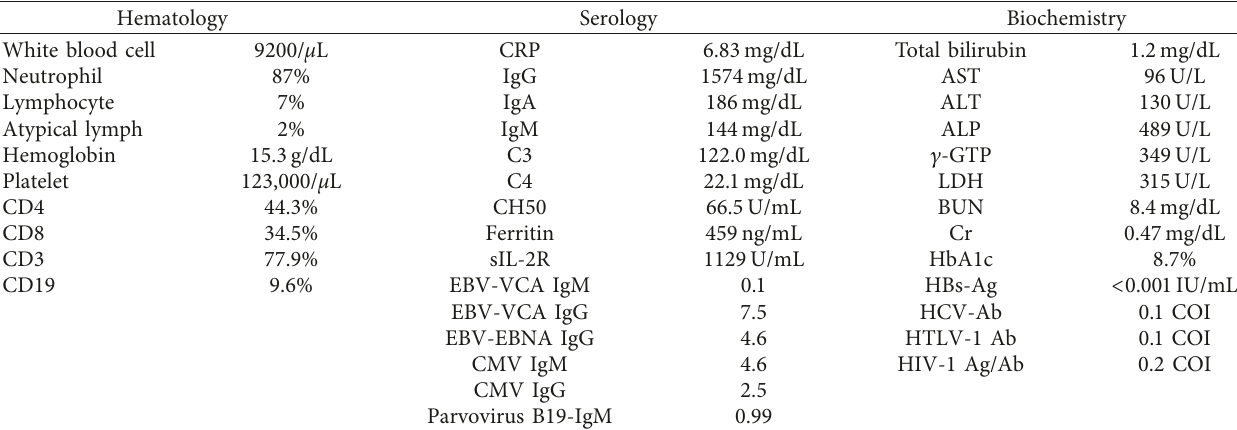
Table 1: Clinical data of this case.